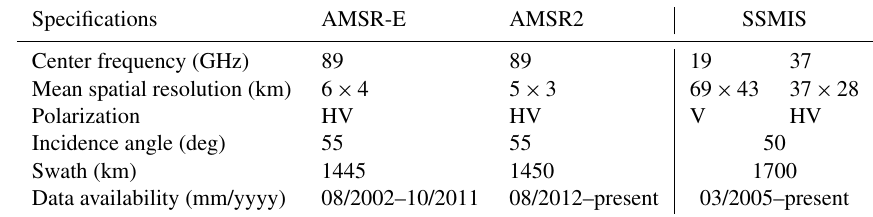
Table 1. Specifications of microwave radiometers used to estimate ice